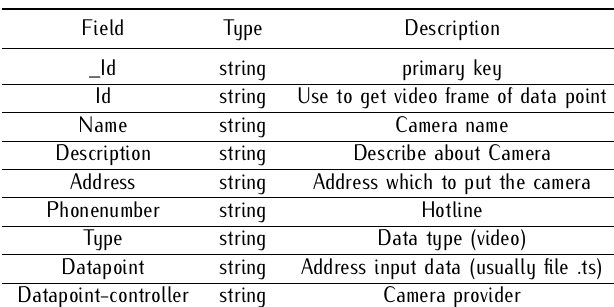
Table 1. public-camera-metadata